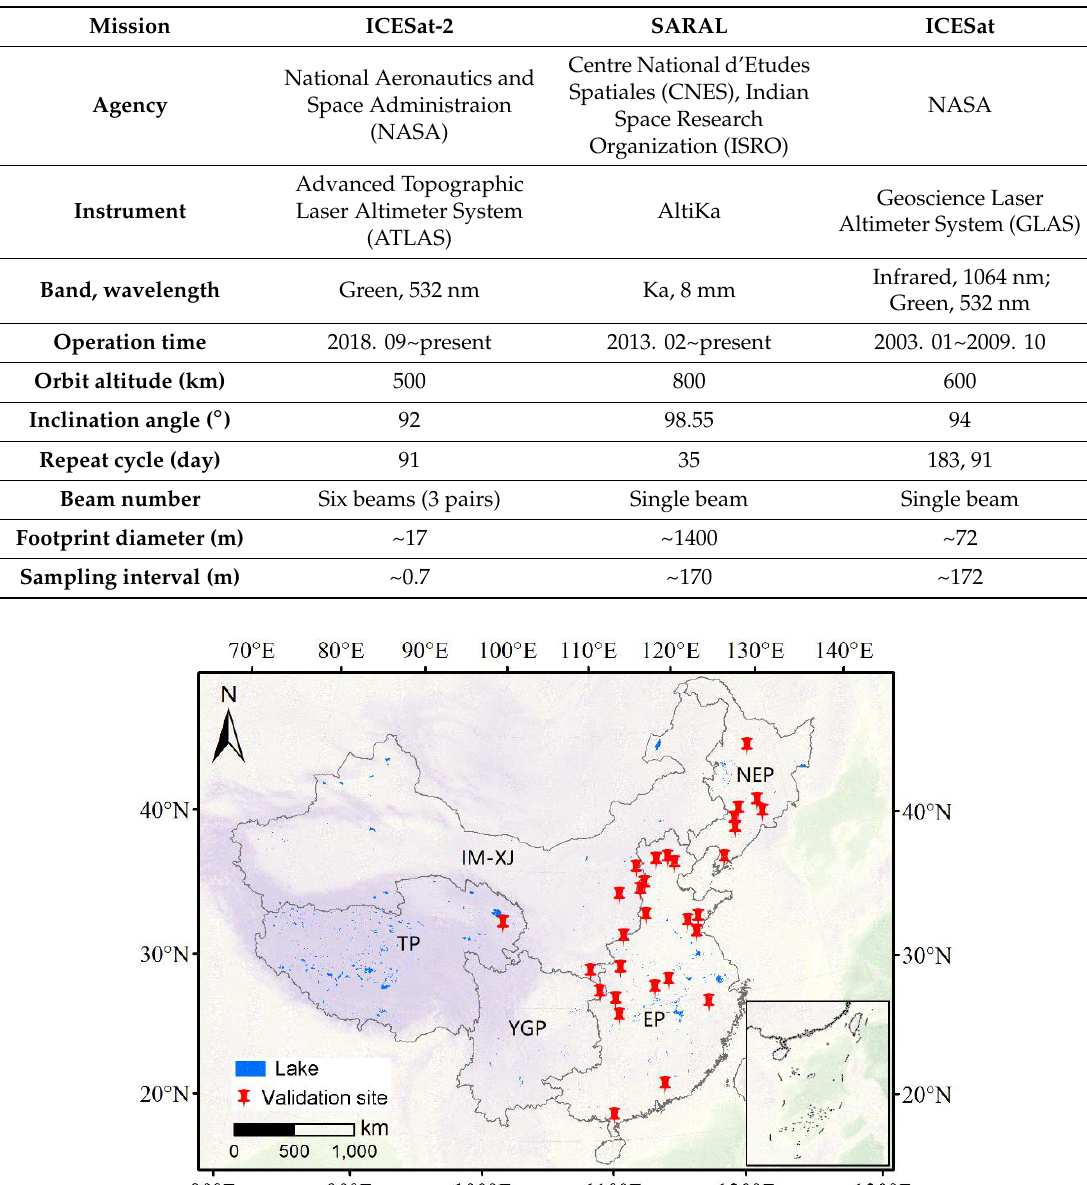
and ALtika (SARAL), and Ice, Cloud, and Land Elevation Satellite (ICESat) missions.